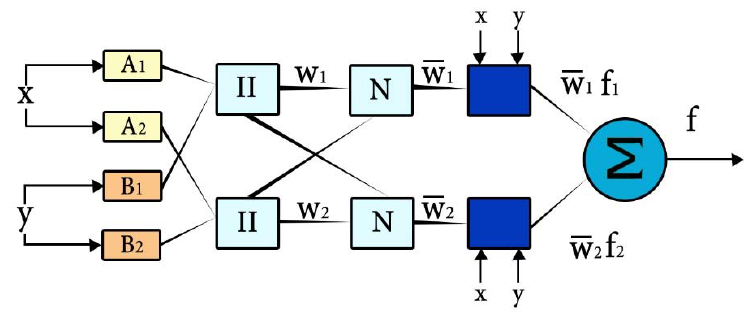
Figure 6. Structure of an ANFIS network.